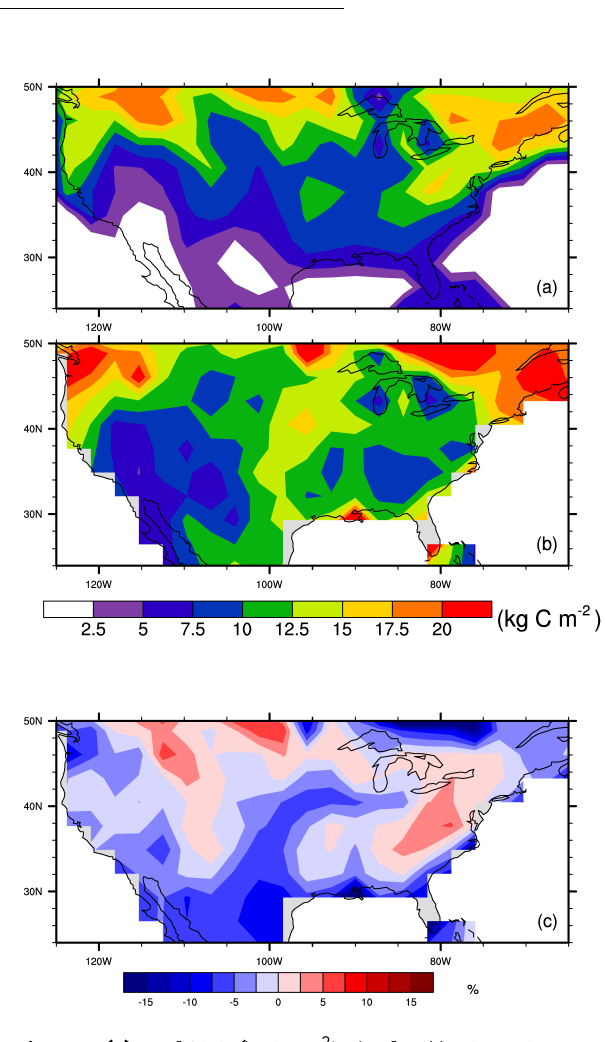
Figure 1. (a) Total SOC (kgCm − 2 ) simulated by CLM-Crop over the contiguous United States. (b) Total SOC from the IGBP over the same domain as in (a) . (c) Percent difference between (a) and (b)